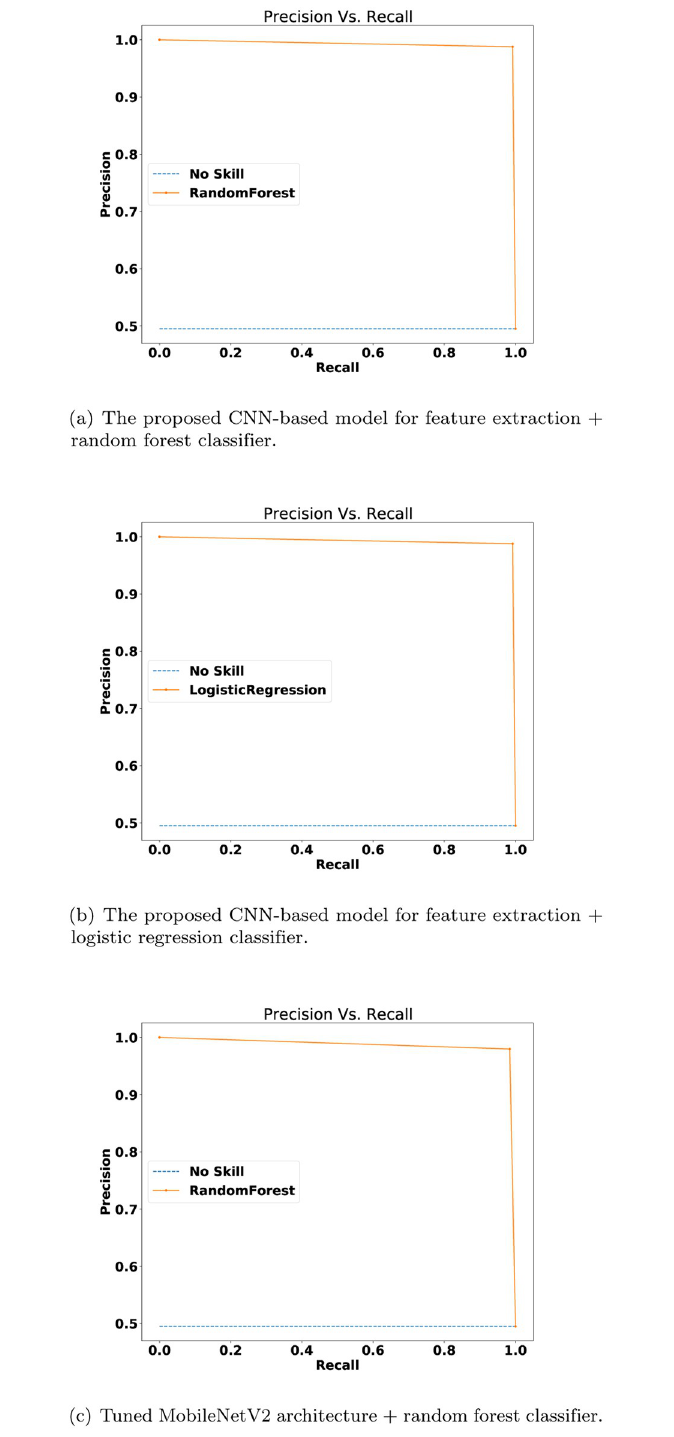
Fig 6. Precision-Recall curves (a) the proposed CNN model+random forest classifier (b) the proposed CNN model +logistic regression classifier (c) tuned MobileNetV2 + random forest classifier.